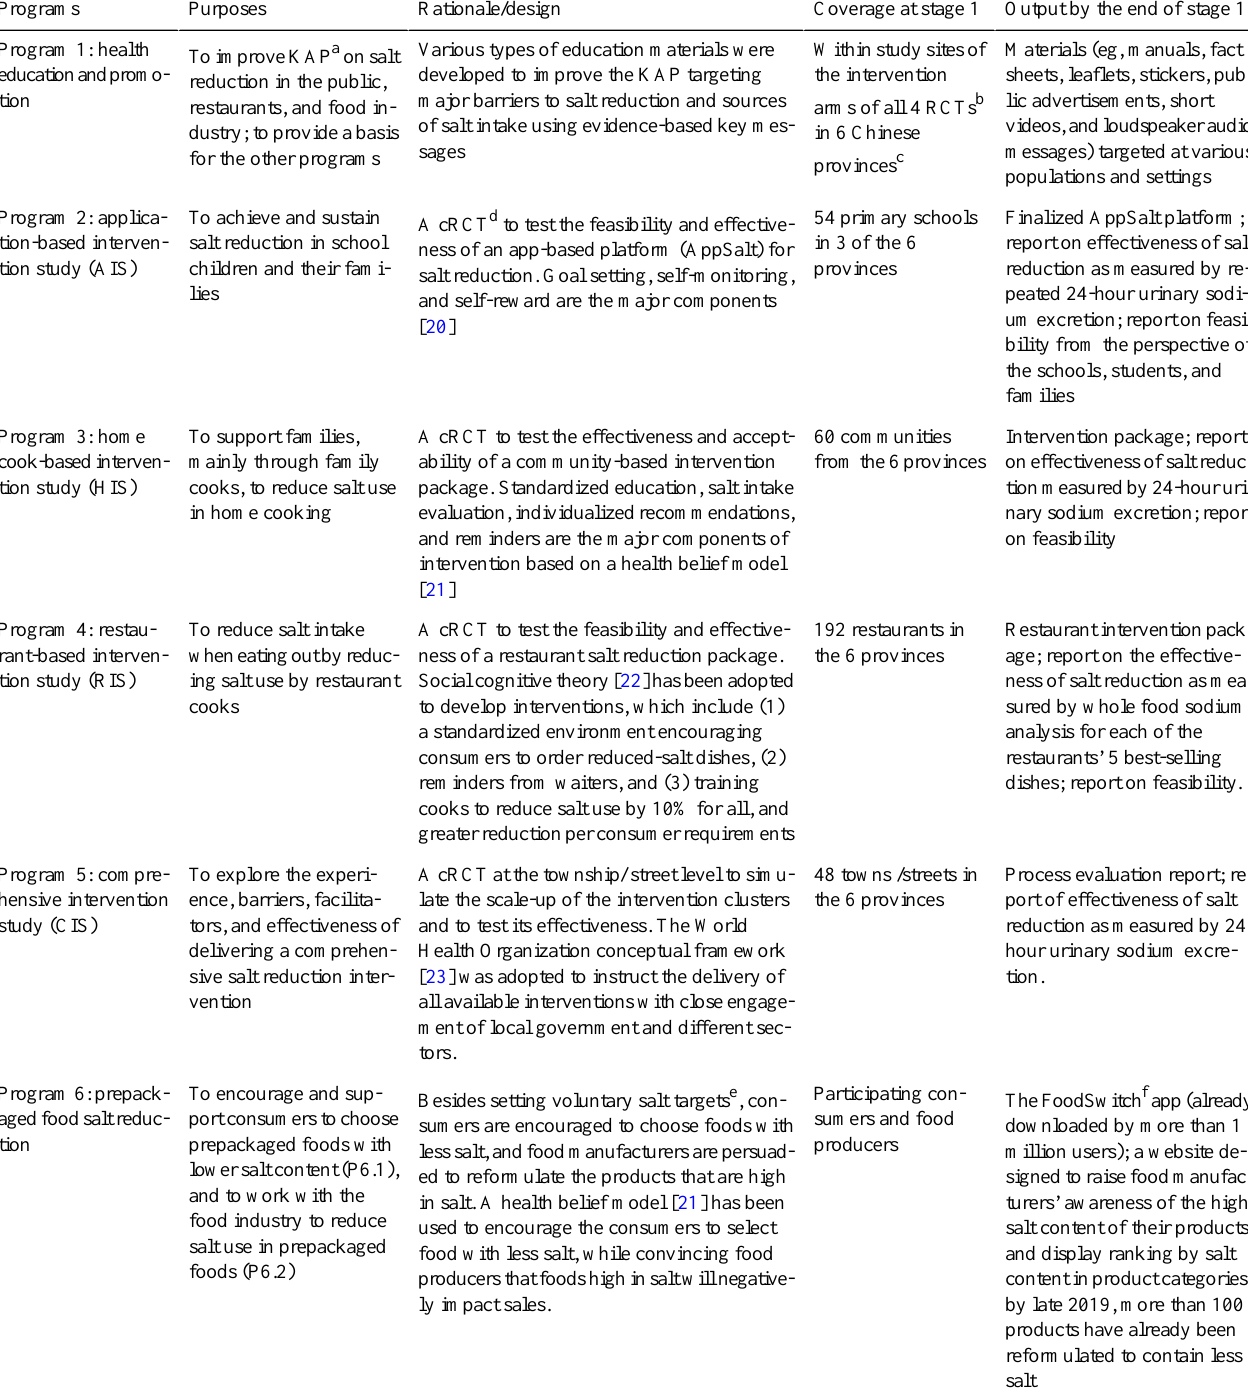
Table 1. Key features of the six programs in Action on Salt China (ASC) at stage 1.